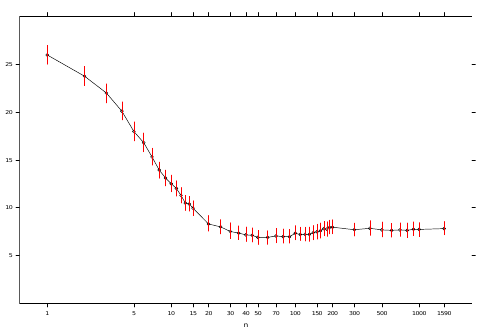
Figure 2: Average Test Error on the copy number data (BAC) for the Lum/ER+ and Basal/ER- task, with 95% student’s bootstrap confidence intervals.